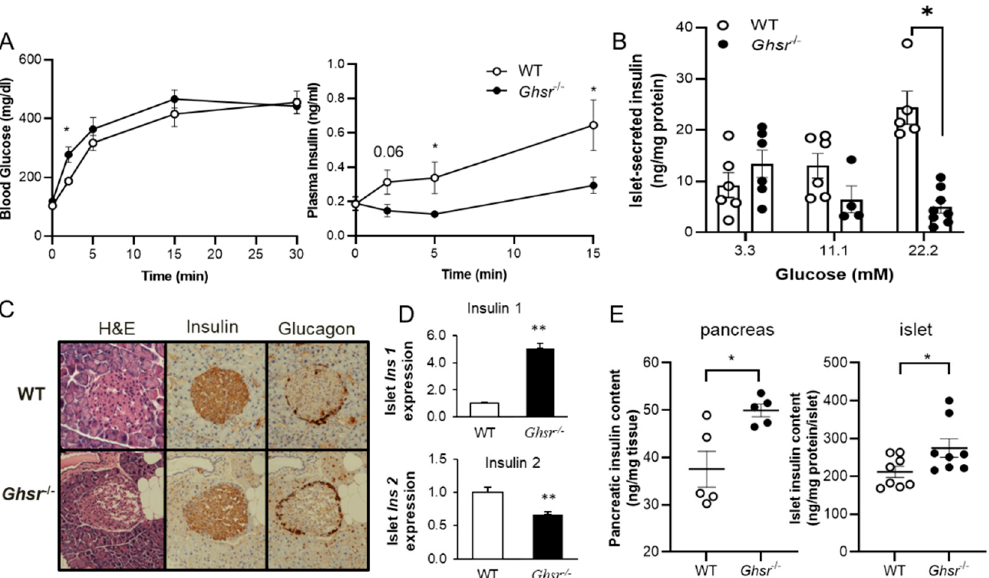
Figure 1. GHS-R ablation decreases glucose-stimulated insulin secretion (GSIS). ( A ) 4.5-month-old WT and Ghsr − / − mice were fasted overnight, and GSIS was performed in vivo, n = 5. ( B ) Islets from 4-month-old WT and Ghsr − / − mice were treated with 3.3, 11.1 or 22. 2 mM glucose for 2 h. Insulin content was measured and normalized to the total protein content of islets, n = 5–8. ( C ) H&E staining and immunostaining of insulin and glucagon of pancreatic sections from WT and Ghsr − / − mice. ( D ) Ins1 and Ins2 gene expression was measured from islets of 6.5-month-old mice, n = 5. (E) Insulin protein content of the whole pancreas (4 months, n = 5) and islet (5.5 m, n = 8) was measured and normalized by total protein content. * p < 0.05, ** p < 0.001, WT vs. Ghsr − / − .